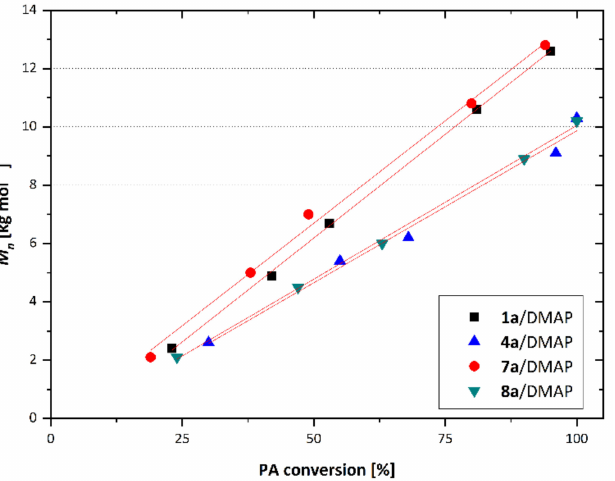
Figure 2. Correlations between PA conversion and M n observed for the amine-bis(phenolate) chromium(III) complexes with different pendant groups (reaction conditions: 110 ◦ C, 2.5 mmol PA and 2.5 mmol CHO in 0.5 mL of toluene, and initial molar ratio of [PA] 0 :[CHO] 0 :[Cr] 0 :[DMAP] 0 =